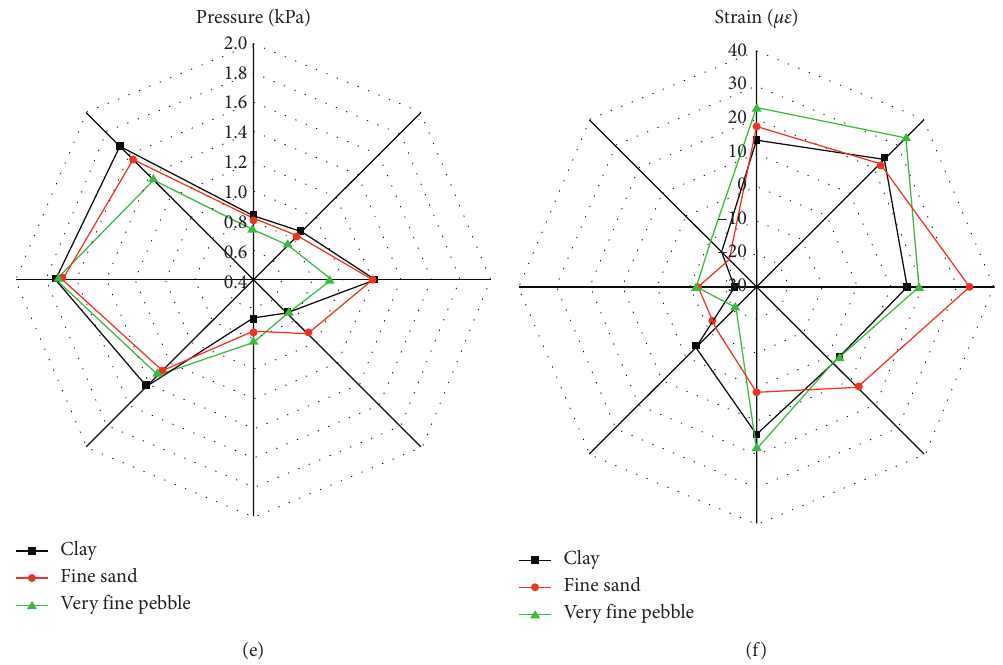
Figure 12: Pressure and strain on the surface of the pipeline which is suspended on the riverbed: (a) pressure on the surface of the pipeline when the embedment ratio is 0, (b) strain on the surface of the pipeline when the embedment ratio is 0, (c) pressure on the surface of the pipeline when the embedment ratio is 0.5, (d) strain on the surface of the pipeline when the embedment ratio is 0.5, (e) pressure on the surface of the pipeline when the embedment ratio is 1, and (f) strain on the surface of the pipeline when the embedment ratio is